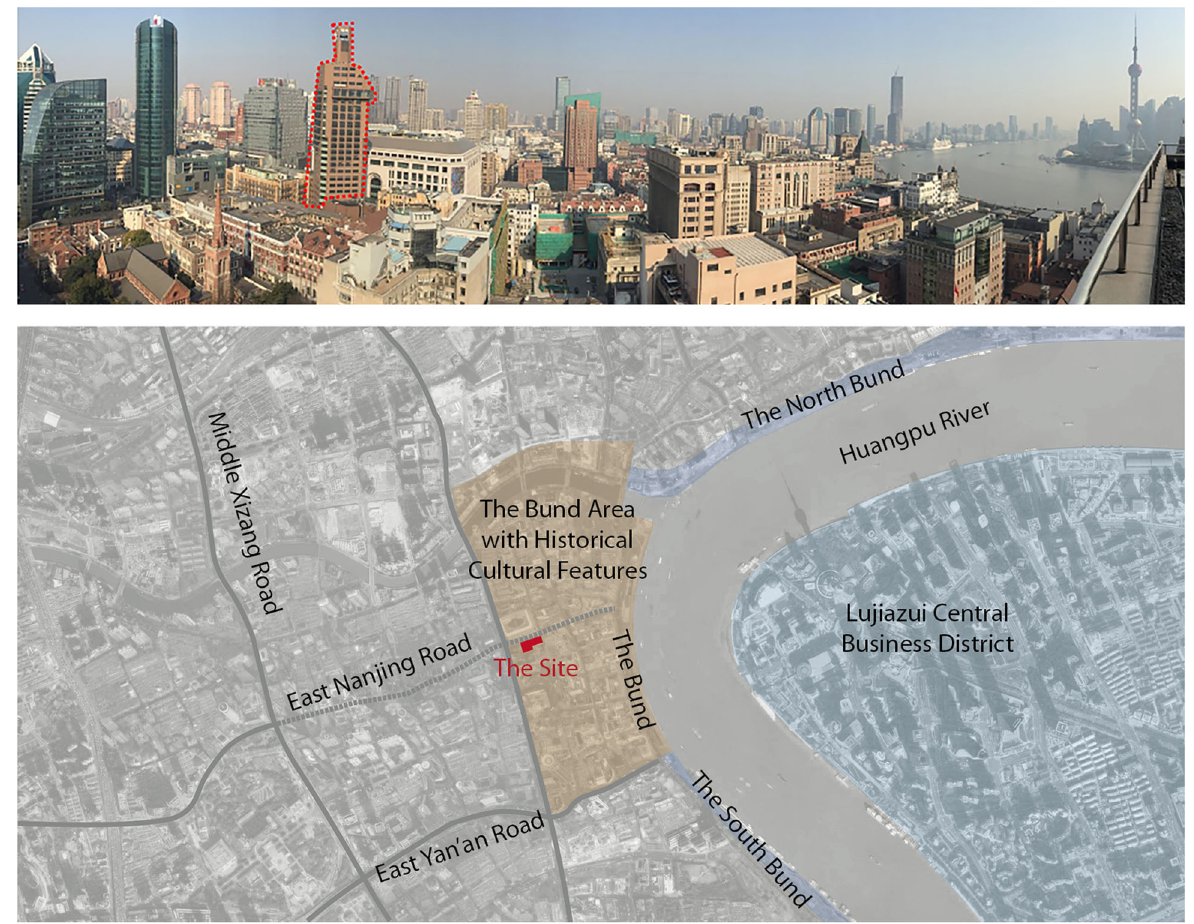
Fig. 1 Location of the SECEP Building (Source: East China Architectural Design & Research Institute